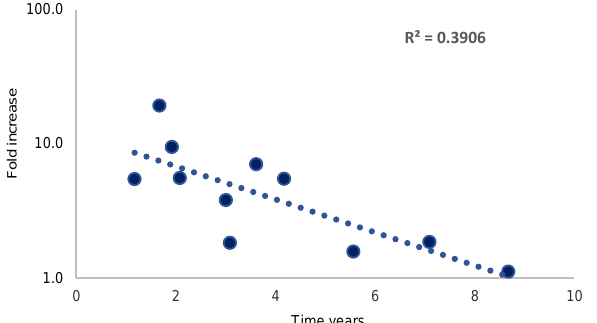
Figure 4. Association between the increase in CETC/CTC numbers over the course of RT and the time to metastasis